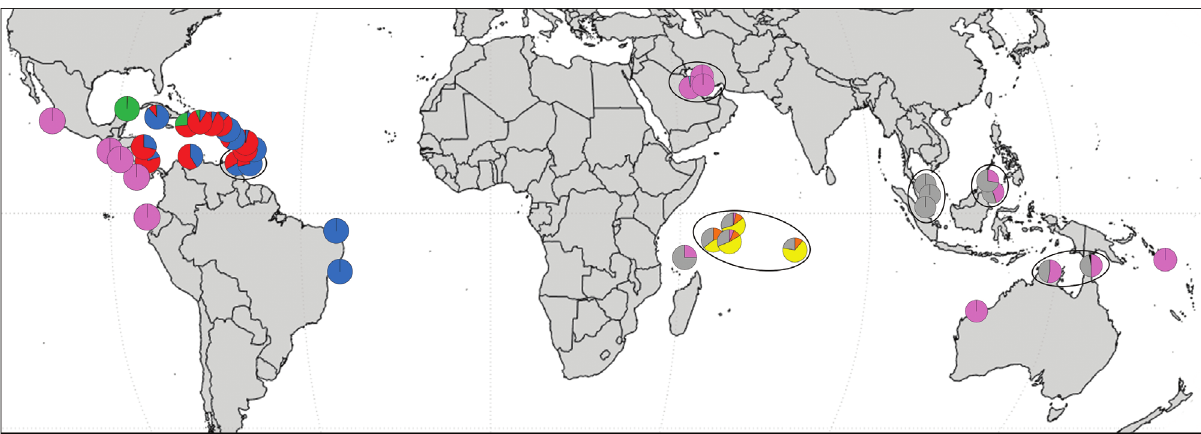
Figure 2 - Frequencies of control region haplotypes (739 bp) from each of nine mtDNA lineages in the hawksbill turtle rookeries. Haplotypes were groupedaccordingtothegeneticlineageidentifiedbyphylogeneticanalysis(seeFigure1)andthepiechartsshowtheproportionofindividualsfromeach rookery that belongs to each clade. Major geographical groups are surrounded by an ellipse on the map (see Table S2 for geographical group names).